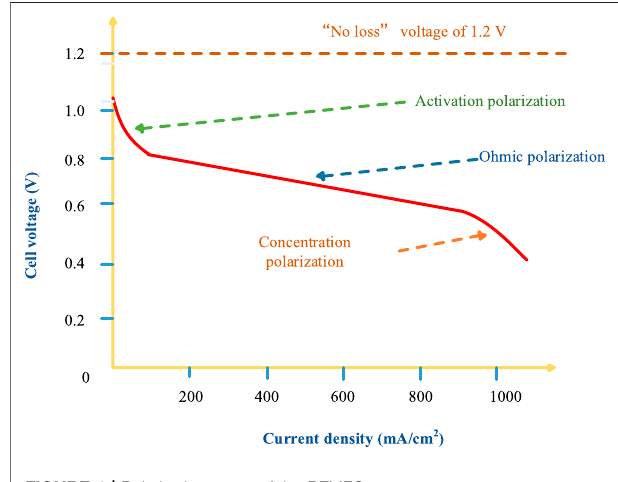
FIGURE 1 | Polarization curve of the PEMFC.